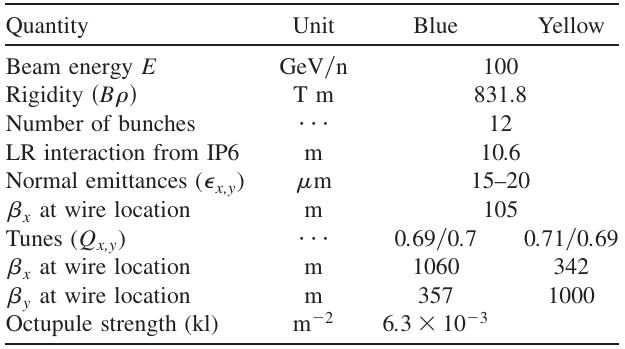
TABLE IV. RHIC parameters for experiments with long-range interactions with proton beams.